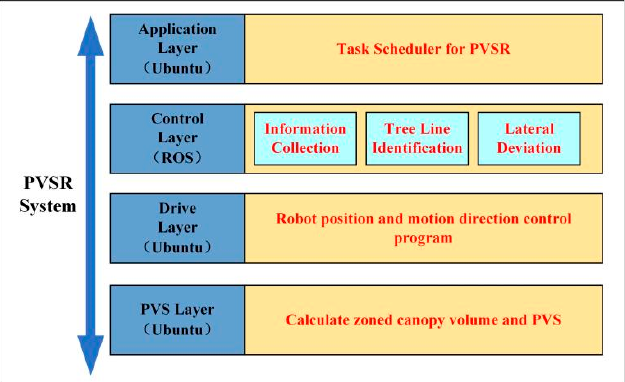
Figure 10. Design of the PVSR software.